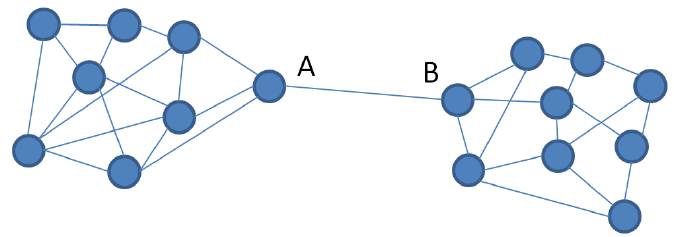
Figure 2. Betweenness